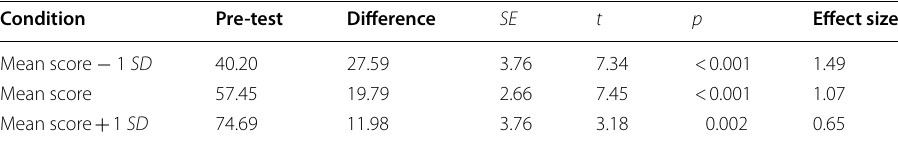
Table 4 Johnson‑Neyman technique analysis for students’ web design skills